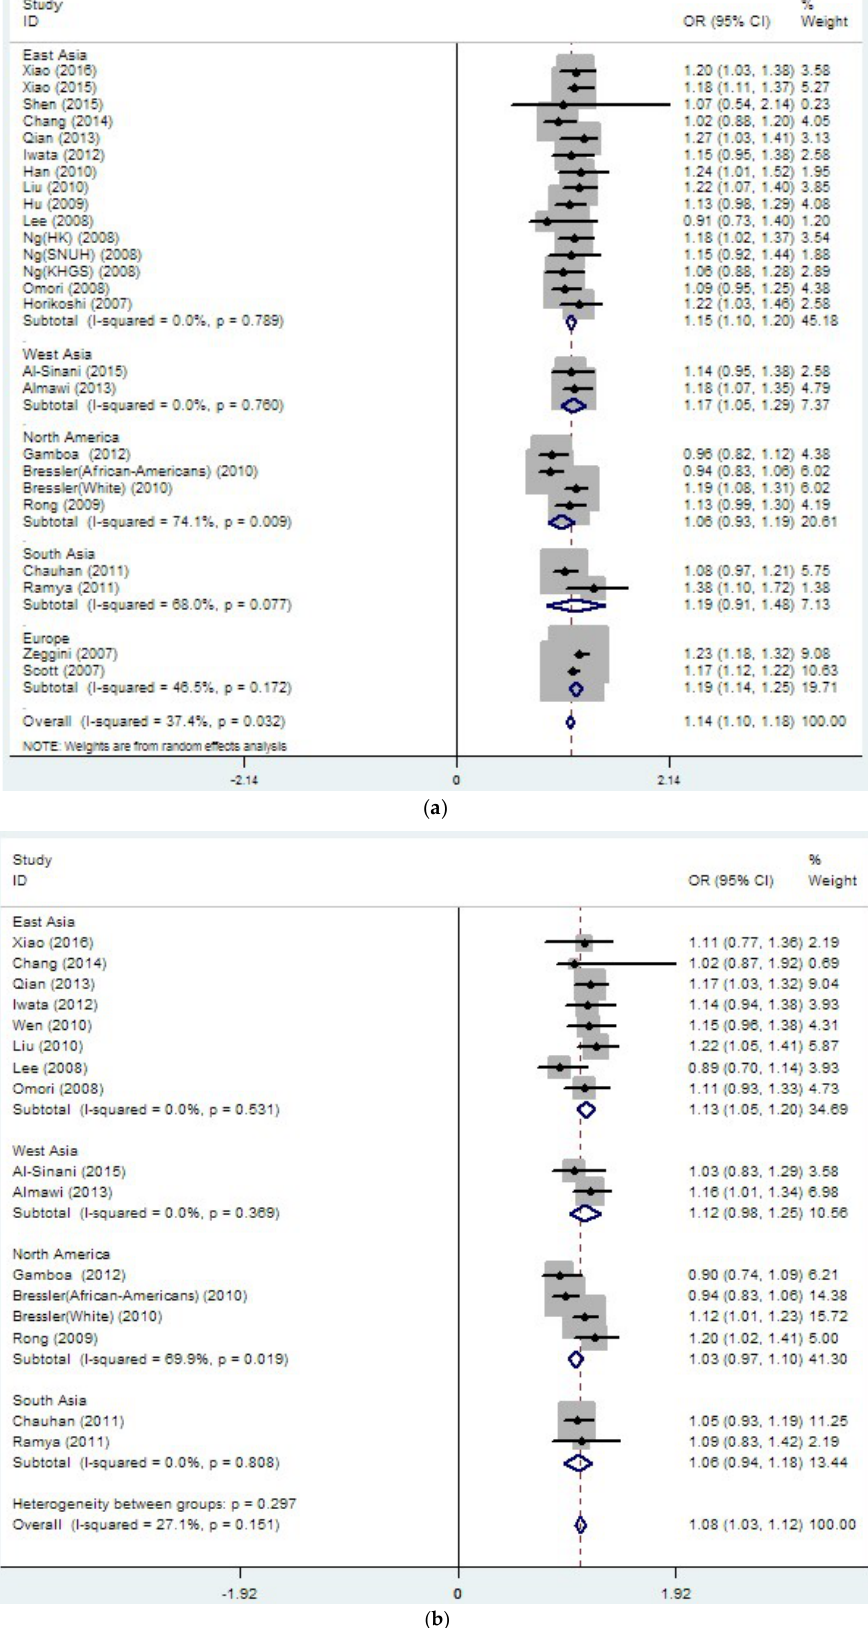
Figure 3. The stratified analysis results of rs8050136 grouped by region: ( a ) without; and ( b ) with adjustment for BMI.